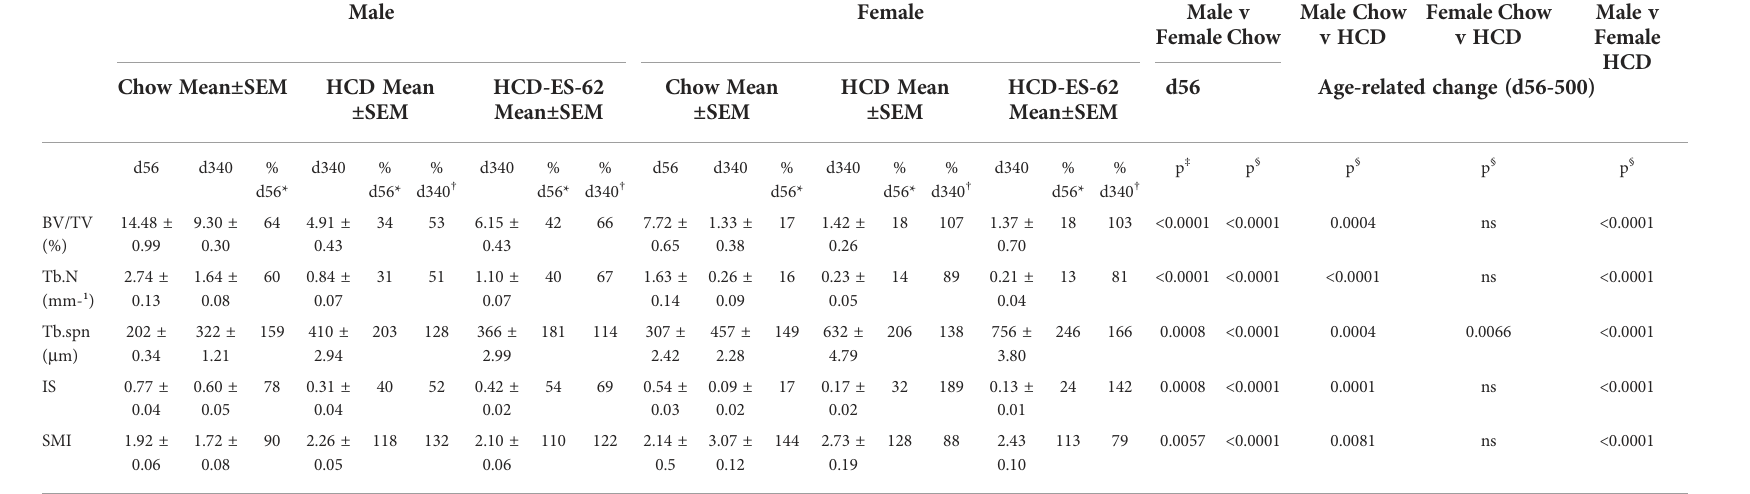
TABLE 1 m ct analysis of femur bone structure during HCD accelerated in ageing male and female C57BL/6J mice.